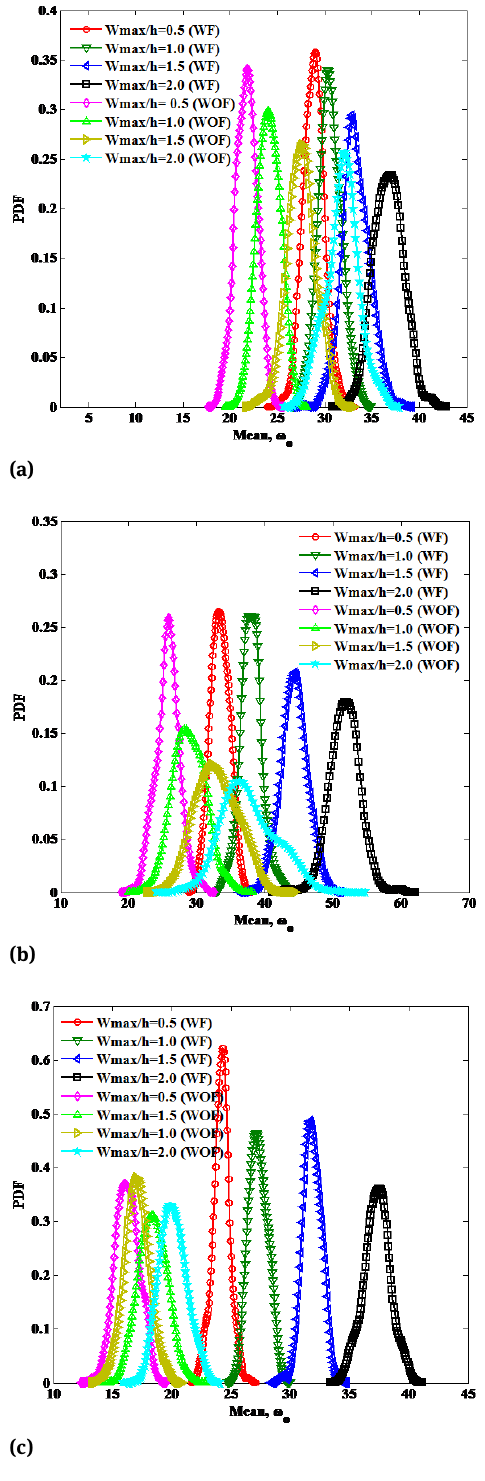
Figure 9: The effect of amplitude ratio on the PDF of nonlinear fun- damental frequency and combined random variables { b i , ( i = 1 to 16) = (0.10) } on COV with and without foundation for (a) UD and (b) FG-X and (c) FG- Λ of CNTRC beams at a / h = 25, V * cn = 0.28 , T = 300 K, COC = 0.10, N = 10 4